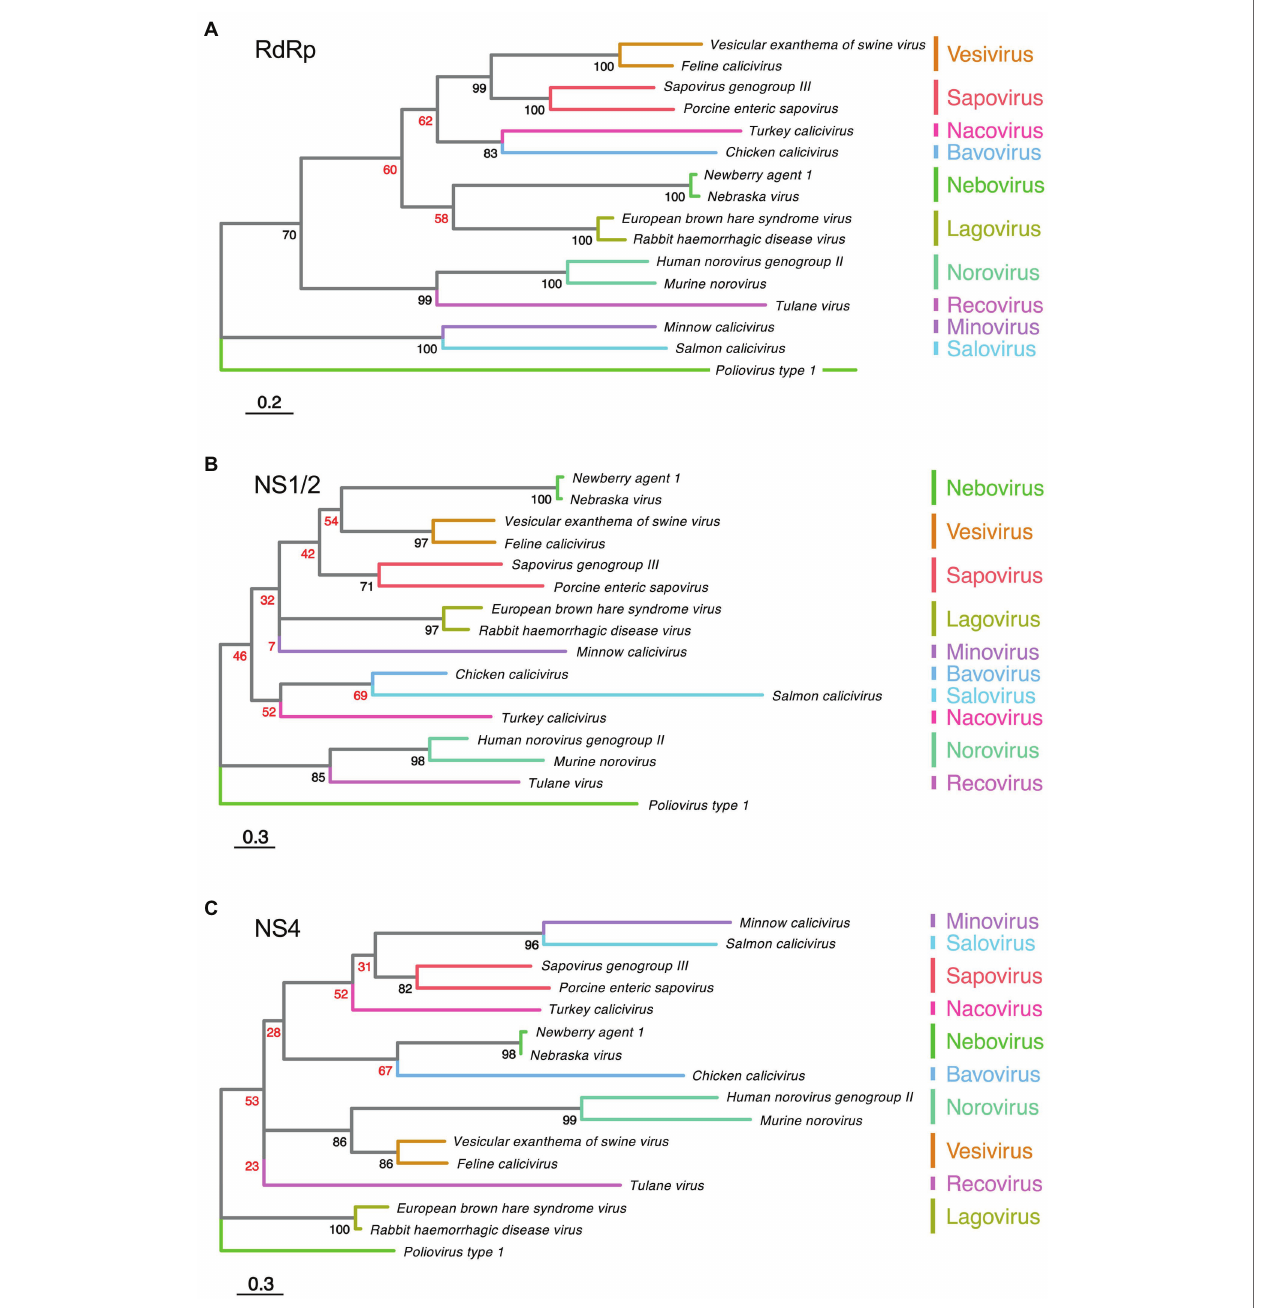
FIGURE 2 | Phylogenetic analysis of calicivirus protein sequences. Maximum likelihood phylogenies were inferred for amino acid sequences of (A) RdRp, (B) NS1/2, and (C) NS4. First, the amino acid sequences of the complete ORF1 coding region of representative published calicivirus sequences were aligned using MAFFT (Katoh et al., 2002). The alignment was then curated with trimAl (Capella-Gutiérrez et al., 2009). The RdRp, NS1/2, and NS4 coding regions were extracted from this complete ORF1 alignment and phylogenies were inferred individually for each gene using IQ-TREE (Nguyen et al., 2015). Phylogenies were rooted using Poliovirus type 1 (GenBank accession NC_002058). The following sequences were chosen for calicivirus genera: Vesicular exanthema of swine virus (VESV; NC_002551), Feline calicivirus (FCV; NC_001481), Sapovirus genogroup III (MG012434), Porcine enteric sapovirus (NC_000940), Turkey calicivirus (NC_043516), Chicken calicivirus (NC_033081), Newbury agent 1 (NC_007916), Nebraska virus (NC_004064), Rabbit haemorrhagic disease virus (NC_001543), European brown hare syndrome virus (EBHASV; NC_002615), Tulane virus (NC_043512), Human norovirus genogroup II (NC_039477), Murine norovirus (MNV; NC_008311), Minnow calicivirus (NC_035675), and Salmon calicivirus (NC_024031). The tree is drawn to scale, with branch lengths measured in the number of substitutions per site. Ultrafast bootstrap values are shown for each node. Low confidence bootstrap values (<70) are highlighted in